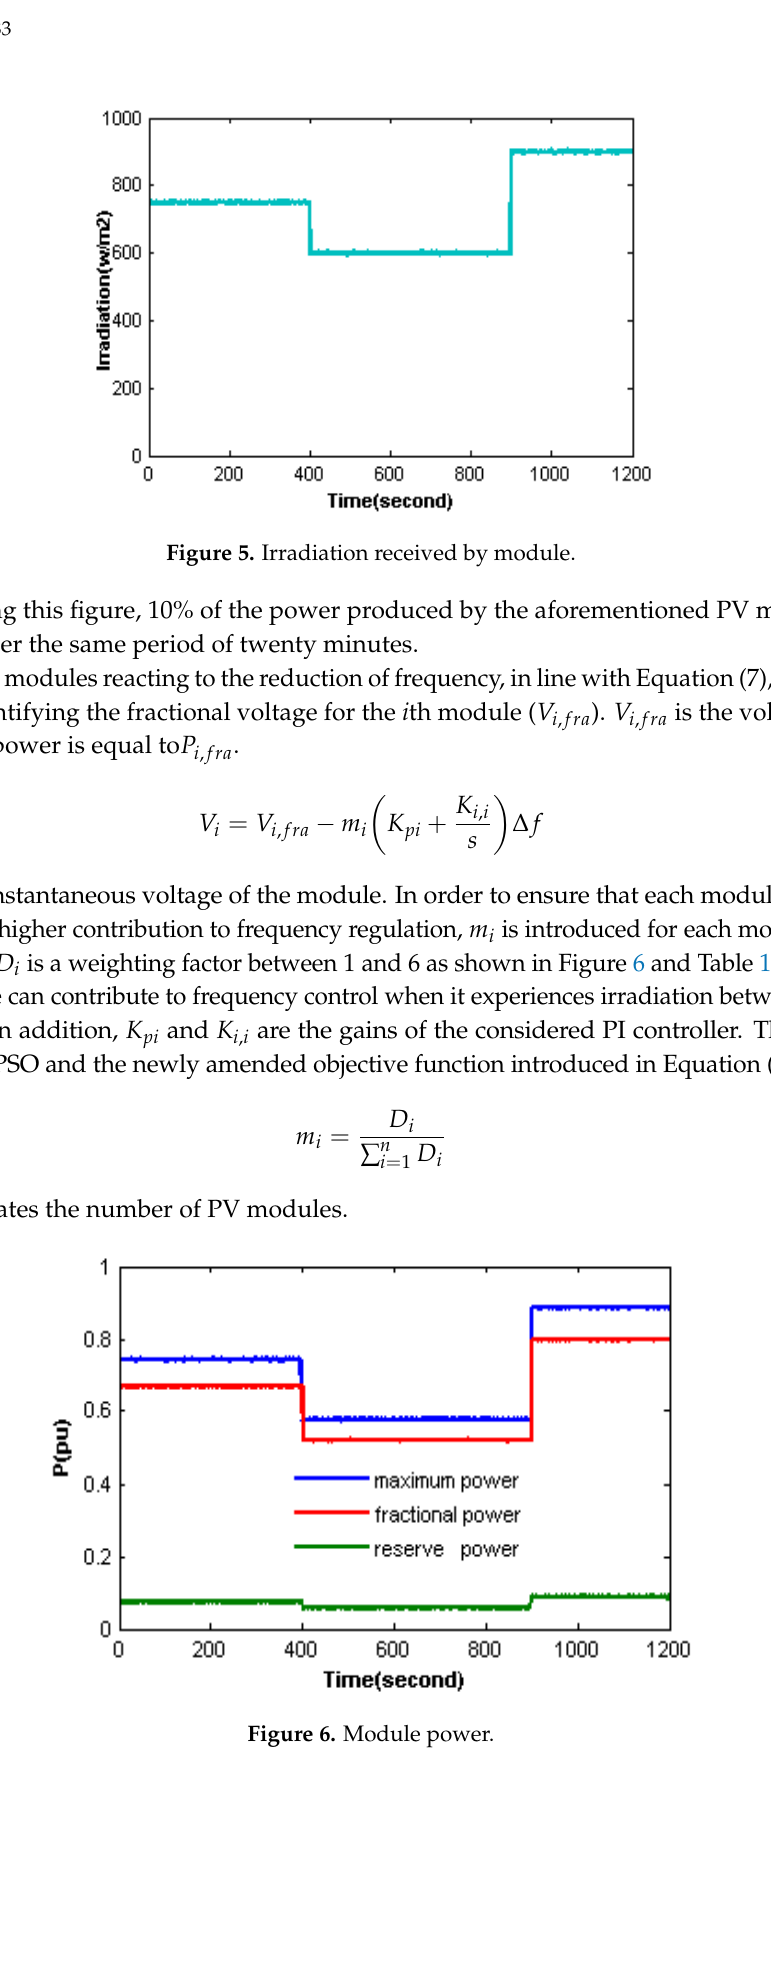
Figure 4. The Power-Voltage curve of a typical module (BP MSX 60).